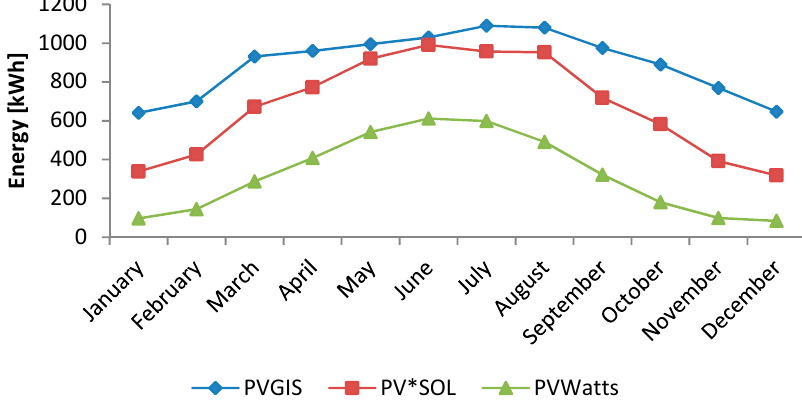
Figure 12. Monthly variation of energy generation for Lefko ş a.